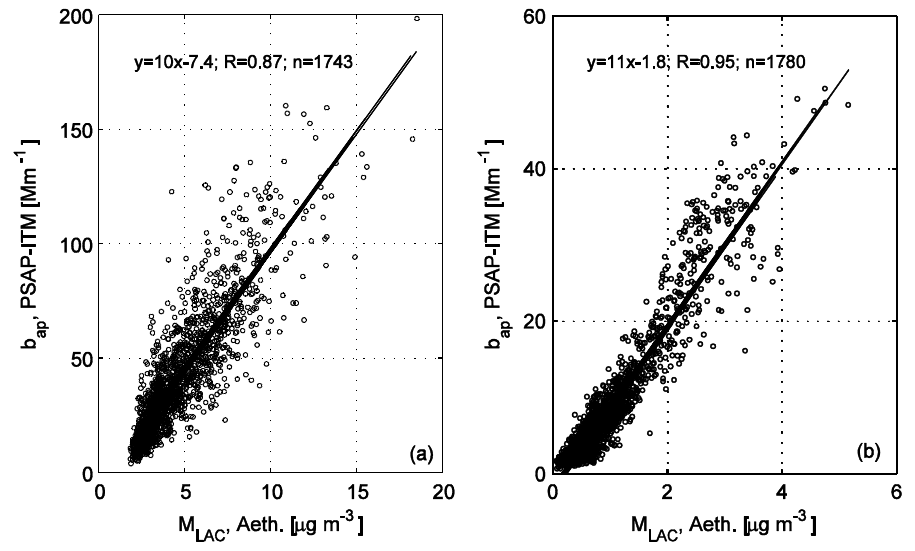
Fig. 3 Fig. 3. Linear correlation between hourly mean PSAP-ITM aerosol absorption coefficients and Aethalometer M LAC in the period 20 April– 5 July 2006. (a) Hornsgatan. (b) Torkel. The regression equation, correlation coefficient R and number of samples n are also displayed. Hornsgatan (left panel) and at Torkel (right panel) in the pe- riod 20 April–5 July 2006. The two methods were found to be highly correlated ( R> 0.85) for both sites, but a large y- intercept ( − 7.2 Mm − 1 ) was observed when correlating the Aethalometer and PSAP-ITM measurements at Hornsgatan, even after subtracting an offset value as described previously.